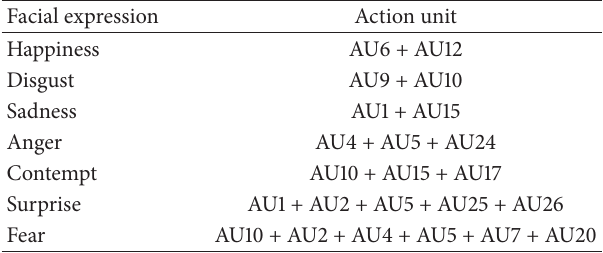
Table 1: Relationship between AU and Expression.